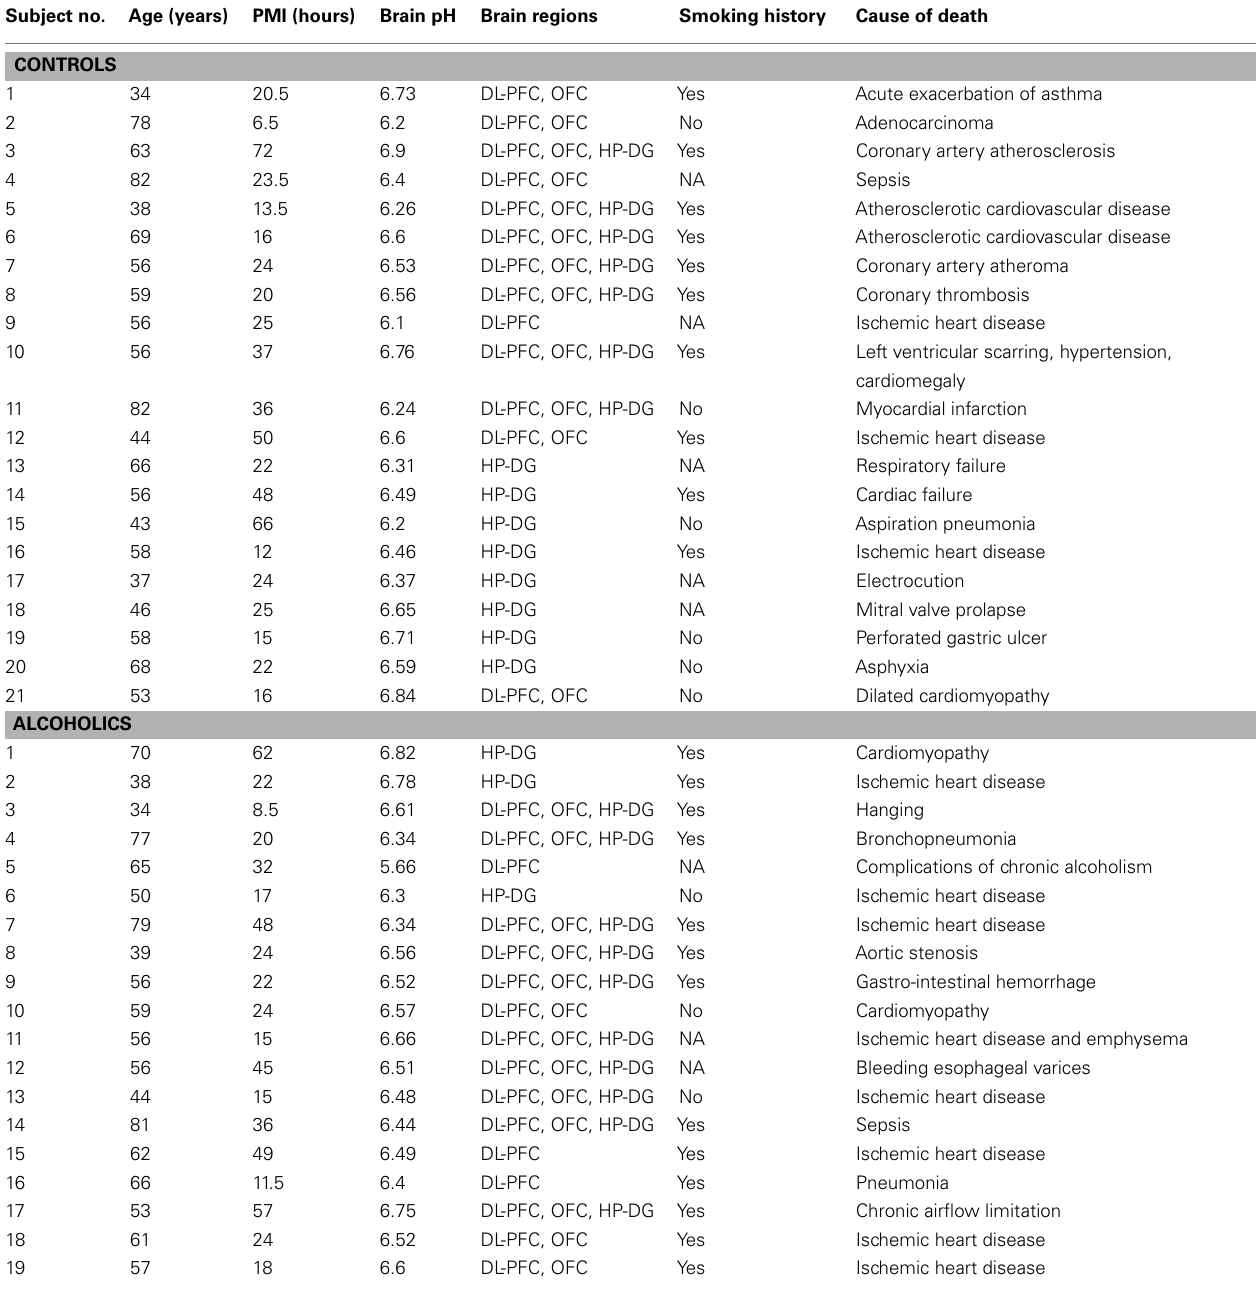
TableA1 | Demographic data of controls and